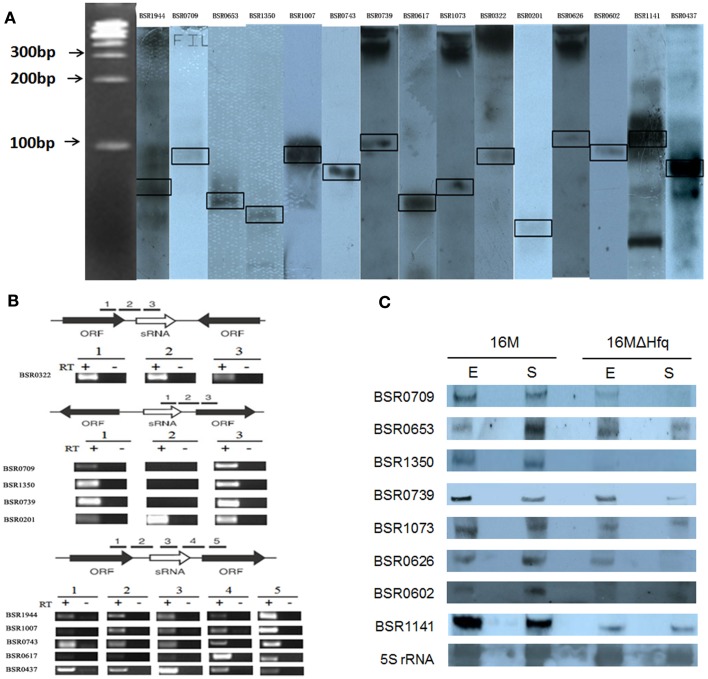
Experimental verification and expression of the sRNAs in B. melitensis. (A) Northern blots verification for the presence of B. melitensis sRNAs. RNA from stationary phase cultures was analyzed by northern blotting using 3′-end DIG-labeled RNA probe complementary to sRNA candidates. (B) RT-PCR verification of the transcriptional unit of sRNA candidates. RNA prepared from wild-type cells grown to stationary phase at 37°C was used for the RT-PCR reaction. The gene organizations around sRNA genes were classified into three groups as schematically represented; the positions and directions of sRNAs and ORFs were represented by white and black arrows, respectively. The regions to be amplified were shown by bars with numbers. +, with reverse transcriptase; −, without reverse transcriptase. (C) Examination of sRNA expression in B. melitensis 16M and 16MΔhfq with northern blot. Total RNA was extracted from the 16M and 16MΔhfq grown in TSB to exponential phase (E) and early stationary phase (S). Northern blot was performed as described in Section “Materials and Methods.” 5S rRNA was used as a positive control. For each sRNA, northern blot analysis was carried out using at least three different RNA samples to ensure the reproducibility of expression profiles.